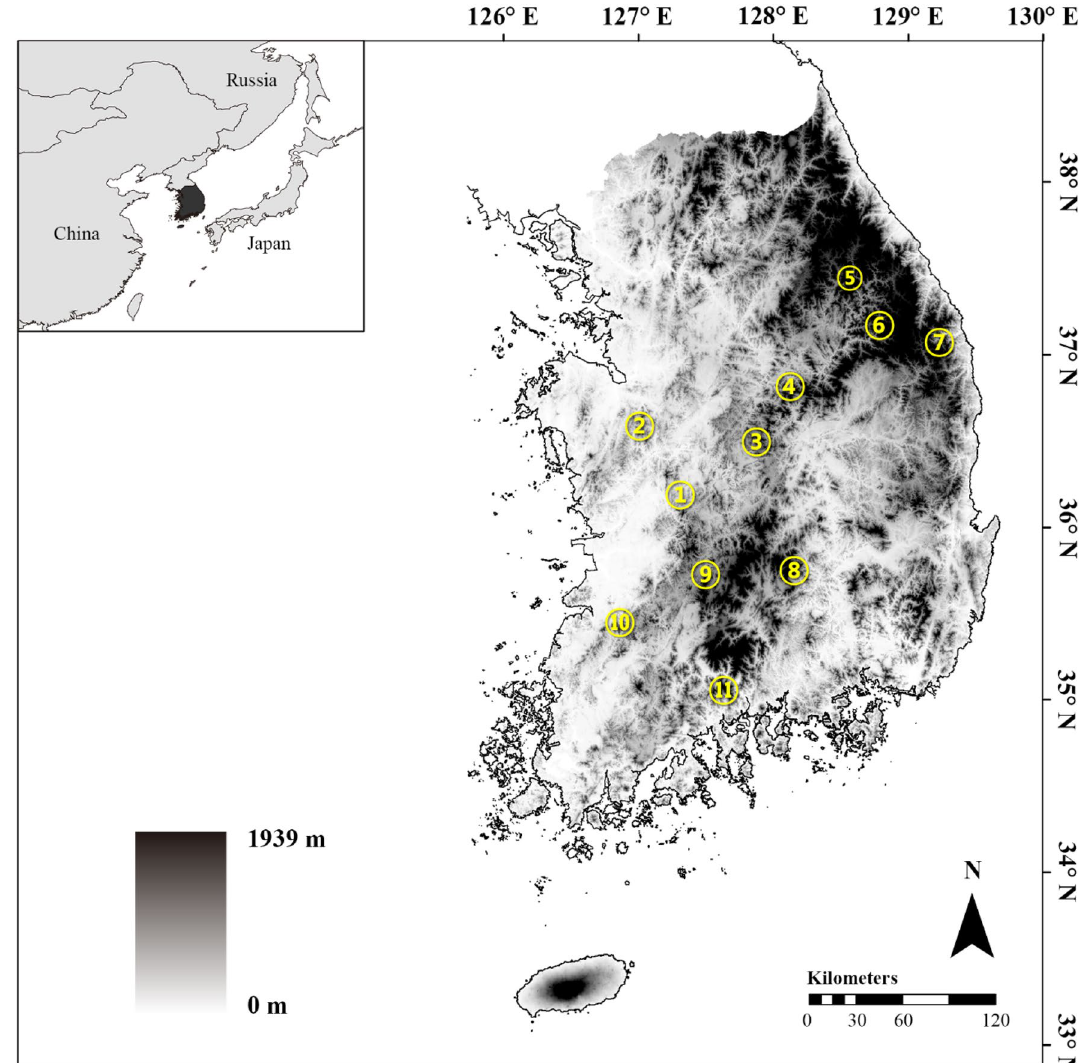
Figure 1. The 11 populations from geographically separate localities of Karsenia koreana throughout the Korean Peninsula in this study; the foundational Digital Elevation Model (DEM) file was obtained from http:// www. biz- gis. com. Altitude is indicated by the relative darkness, with black being higher elevations. Sites designated as numbers on the map represent the following populations: 1: DaeJeon (DJ), 2: GongJu (GJ), 3: BoEun (BE), 4: JeCheon (JC), 5: PyeongChang (PC), 6: JeongSeon (JS), 7: SamCheock (SC), 8: HapCheon (HC), 9: JinAn (JA), 10: JeongEup (JE) and 11: GwangYang (GY). For the detailed sampling information, see Table